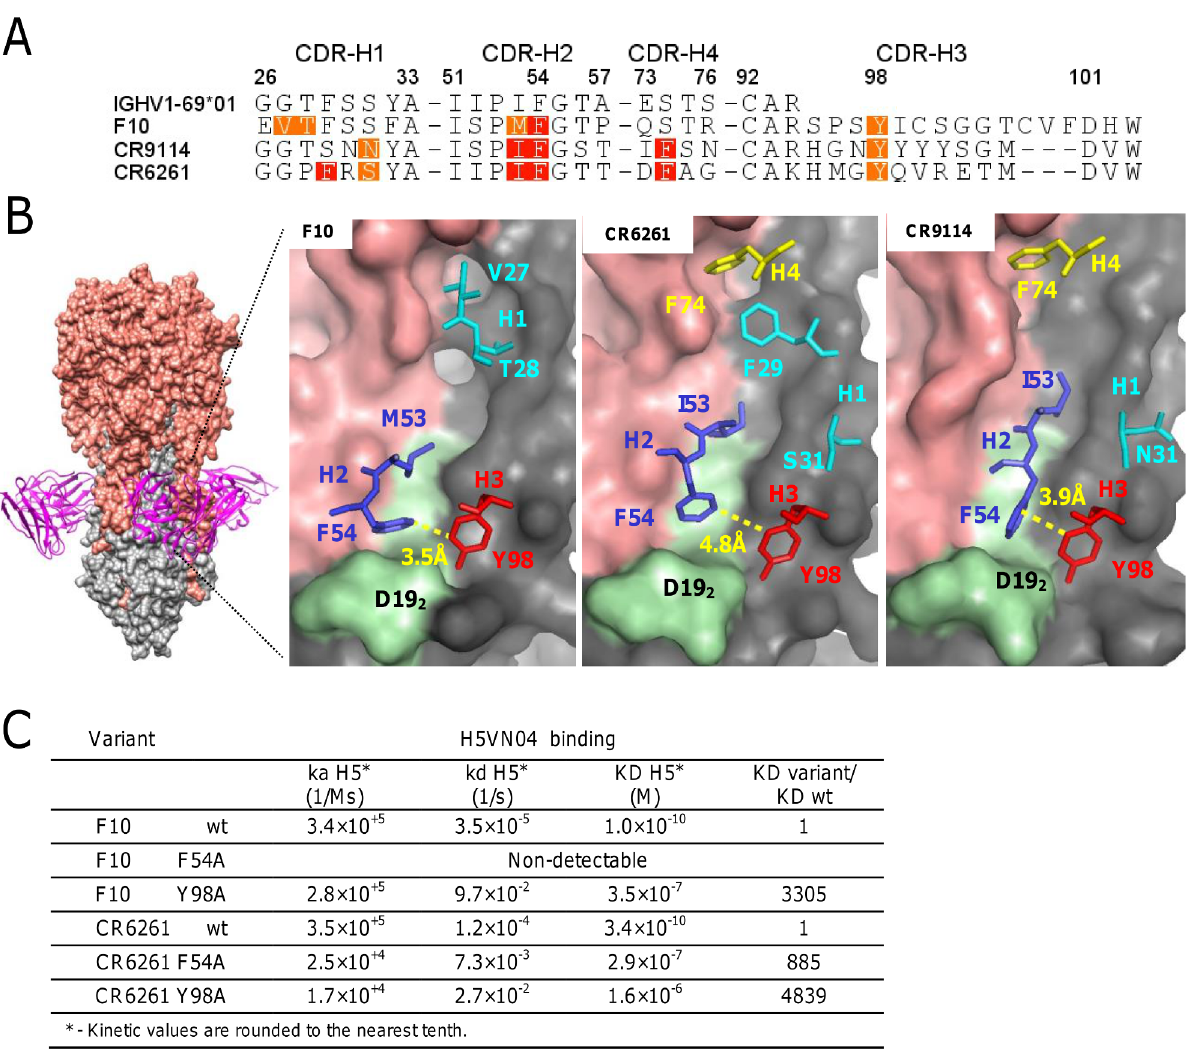
Figure 1. The structural basis of HV1-69-sBnAb similarity. A ) The ANCHOR web server [25] was used to identify heavy chain CDR residues that make favorable contacts ( 2 1 kcal/mol .2 3 kcal/mol orange) and highly favorable binding contacts ( ,2 3 kcal/mol red) in the co-crystal structures of F10 (PDB: 3FKU) CR6261 (PDB: 3GBM), and CR9114 (PDB: 4FQI). B ) Left - The location of F10 binding on the HA is shown with HA1 colored in salmon and HA2 colored in grey. Right panels – The location of the CDR residues identified in A ). In light green is the HA2 fusion peptide from Trp21 2 -to-Val18 2 . C ) Binding kinetics data of F10, CR6261, and the respective variants of F10 F54A, F10 Y98A, CR6261 F54A and CR6261 Y98A, against